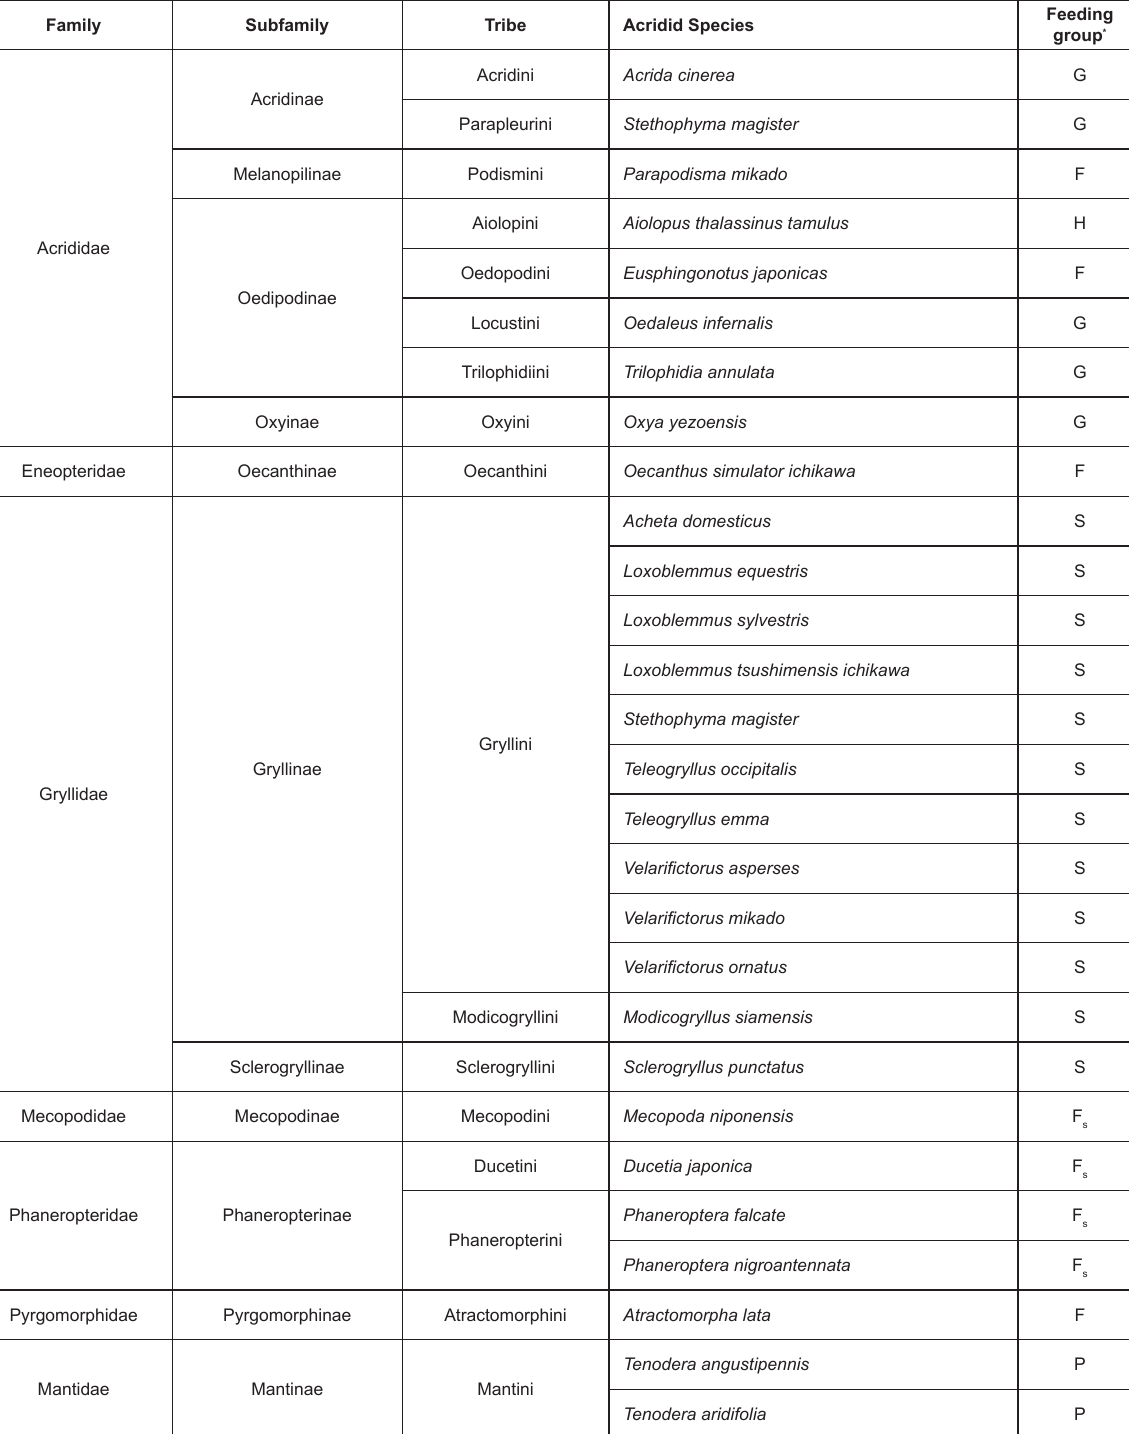
Table 1. Check-list of orthopteran species inhabiting different habitats of Satoyama area with their family, subfamily, tribe and feeding Family